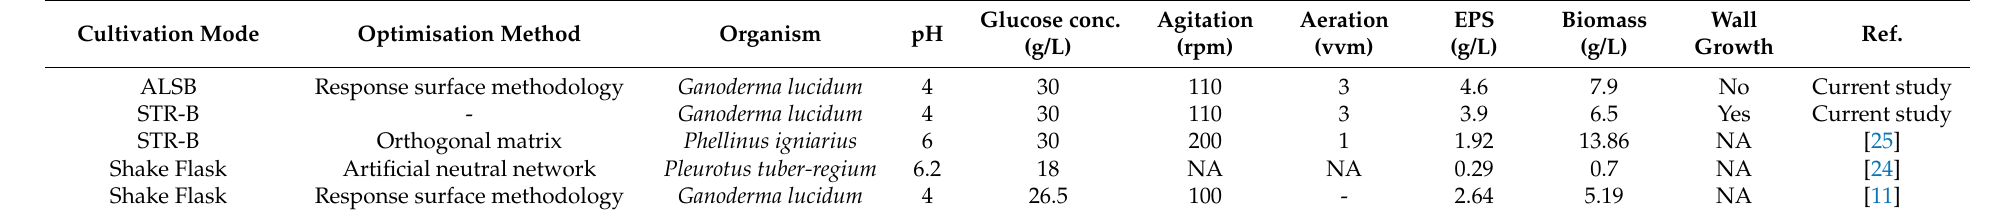
Table 7. Comparison of ALSB optimisation using submerged liquid fermentation in a different cultivation method with